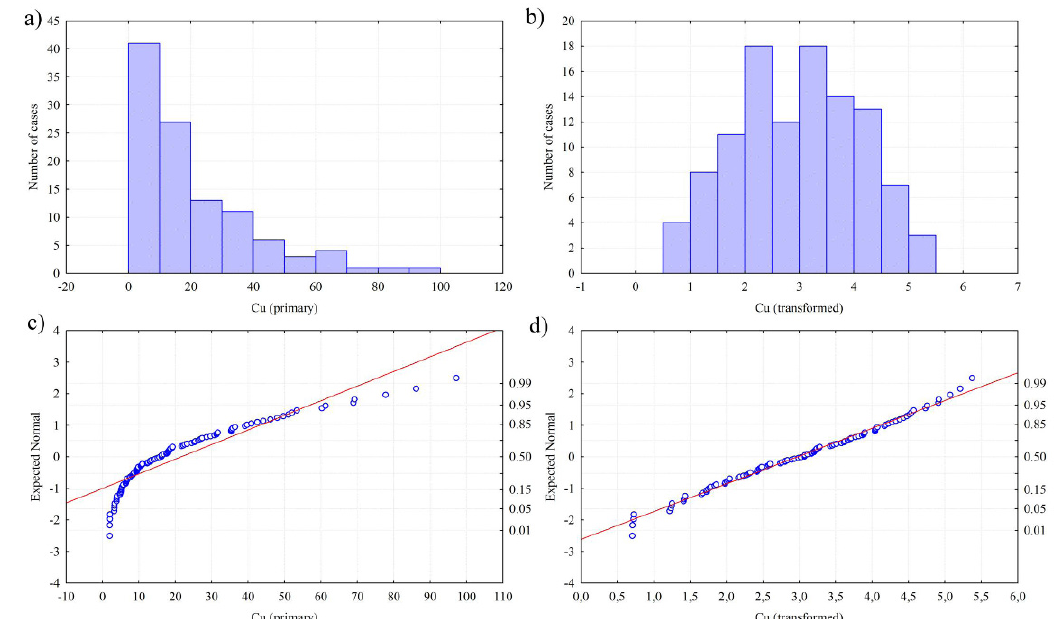
Figure 2. Histogram and normal plot of raw data and data subjected to the Box-Cox transformation for